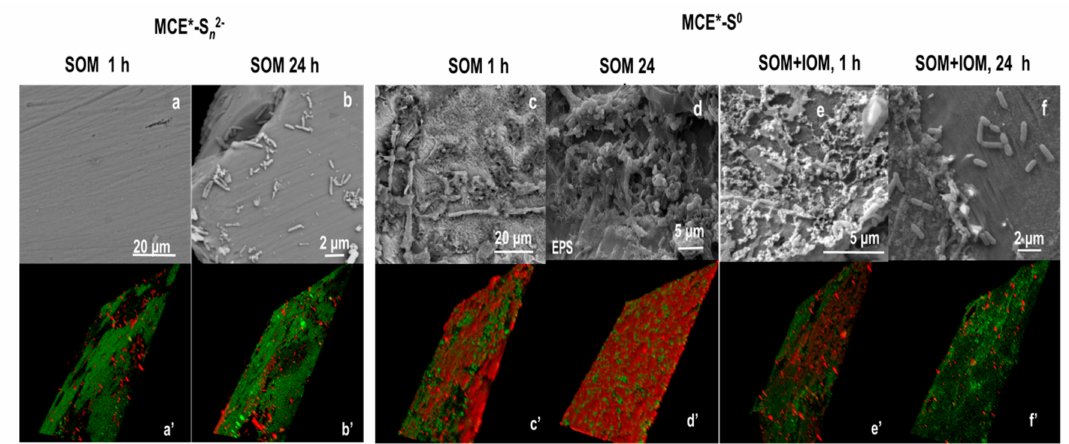
Figure 3. Environmental scanning electron microscopy (ESEM) and confocal laser scanning microscopy (CLSM) images of the MCE*-S n 2 − with SOM ( a , b ) and ( a’ , b’ ), and of the MCE*-S 0 with SOM ( c , d ) and ( c’ , d’ ) and SOM+IOM ( e , f ) and ( e’ , f’ ) after 1 and 24 h. Epifluorescence (CLSM) of hydrophilic compounds as exopolysaccharides is shown in green, and that of hydrophobic compounds is shown in